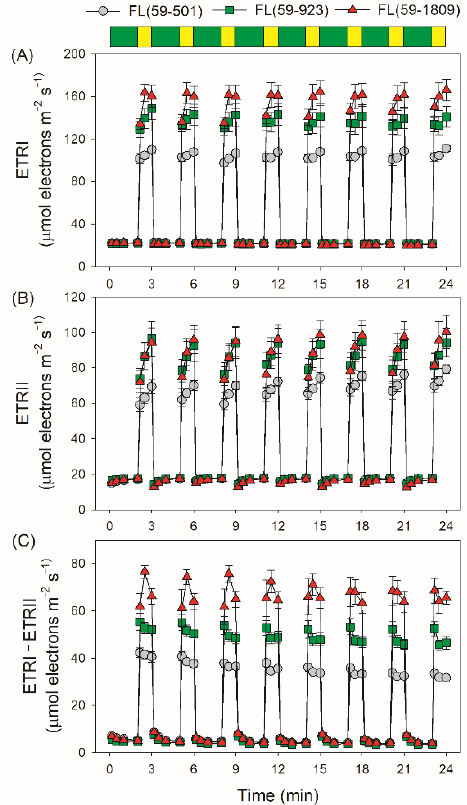
Figure 3. Changes in the electron transport rates under different fluctuating light conditions. After light adaptation at 1455 µ mol photons m − 2 s − 1 for 5 min to activate photosynthetic electron sinks, leaves were exposed to fluctuating light alternating between low (59 µ mol photons m − 2 s − 1 , 2 min) and high light (501, 923 or 1809 µ mol photons m − 2 s − 1 , 1 min). The ETR values were calculated in low light (10 s, 30 s, 60 s and 120 s) and high light (10 s, 30 s and 60 s). ( A ) ETRI, ETR through PSI; ( B ) ERTII, ETR through PSII; ( C ) ETRI − ETRII, estimated rate of cyclic electron flow. Data are shown as means ± SE ( n = 5). Green bars indicate low light (59 µ mol photons m − 2 s − 1 ); yellow bars indicate high light (501, 923 or 1809 µ mol photons m − 2 s − 1